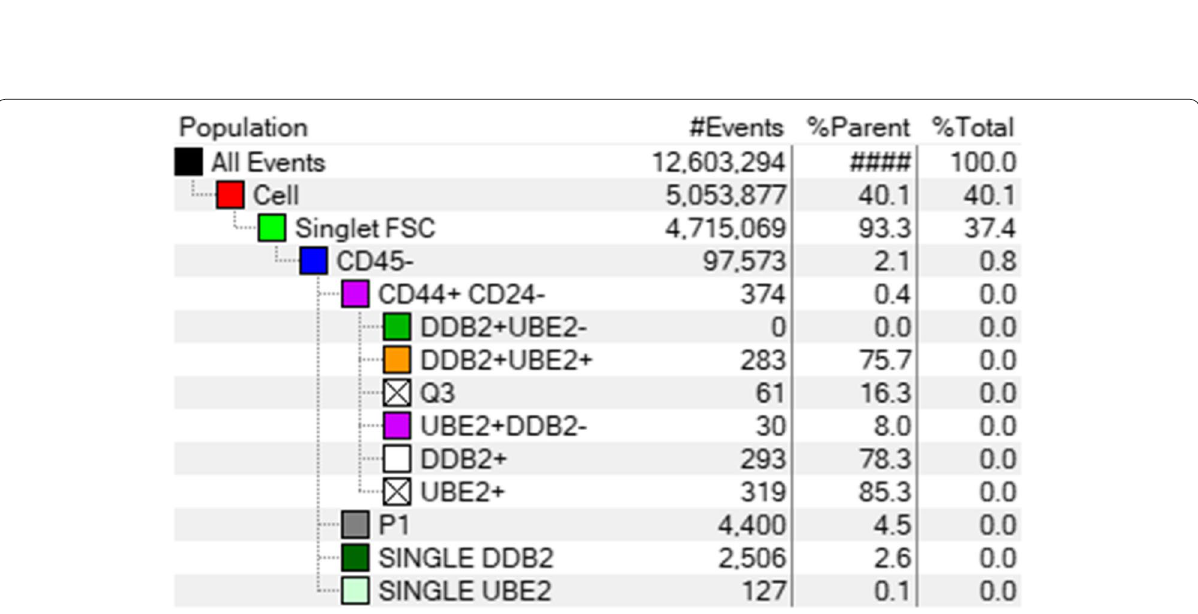
Fig. 2 The flow cytometry cell count results. CD44 + /CD24 - was calculated based on the proportion of purple cells from the Total